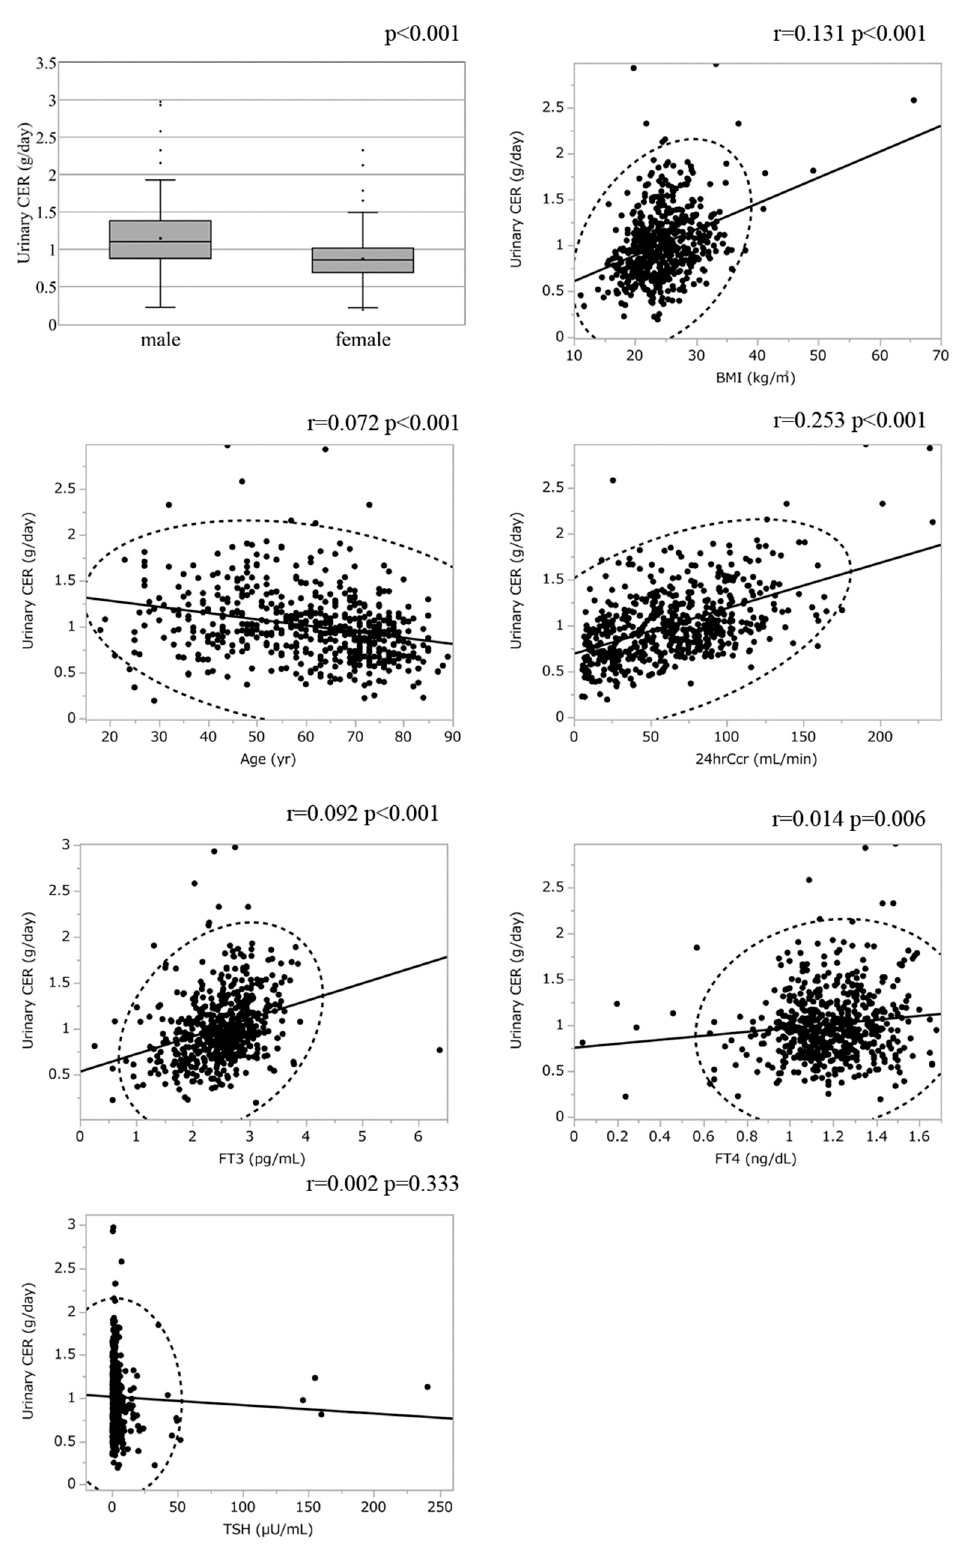
Figure 2. The association between urinary creatinine excretion rate and variables. Urinary CER, urinary creatinine excretion rate; eGFRcre, estimated glomerular filtration rate calculated by serum creatinine; BMI, body mass index; 24hrCcr, 24 h creatinine clearance; FT4, free thyroxine; TSH, thyroid-stimulating hormone; FT3, free